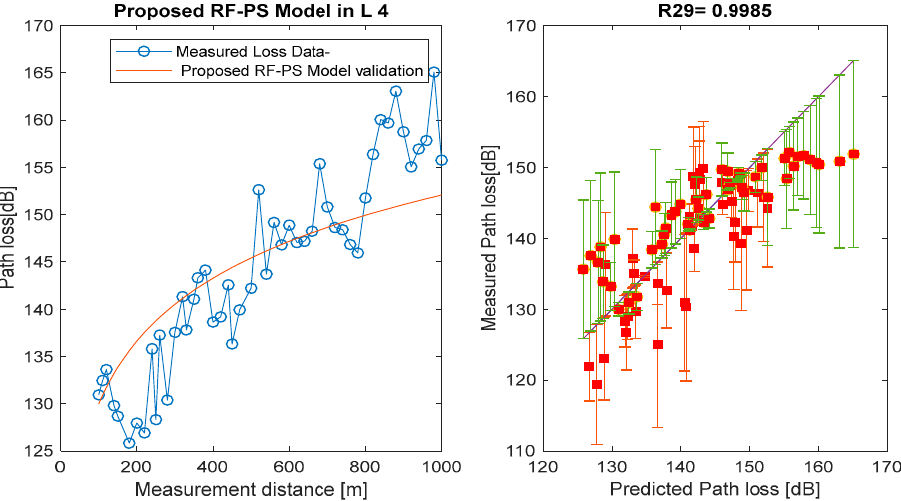
Figure 35. Measured path loss and the proposed hybrid RF-PS model prediction validation plot using another site in location 4.